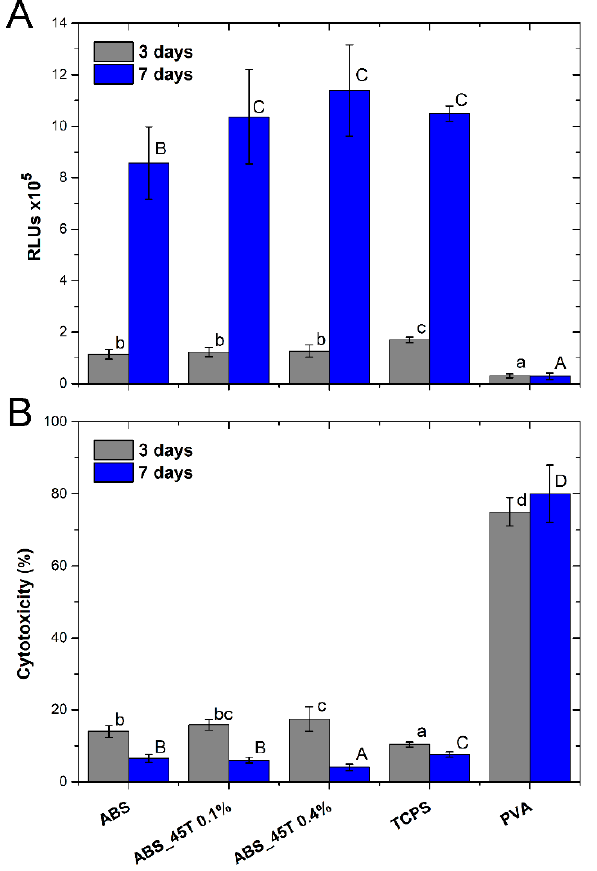
Figure 5. Relative number of cells ( A ) and cytotoxicity of materials ( B ) assessed in direct contact with Hs-680.Tr cells. The results are presented as mean values ± standard deviation. Statistically significant differences ( p < 0.05) between the tested materials are marked a–c for 3-day culture and A–D for 7-day culture.